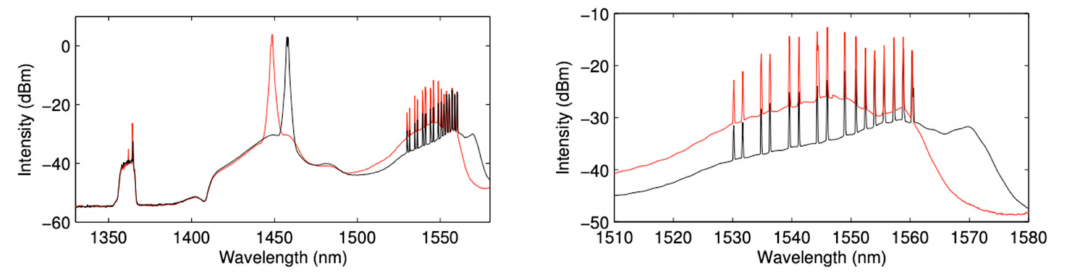
Figure 2. The Raman gain shift using FBGs centered at 1448 nm (red) and 1458 nm (black). The right figure is zoomed on the 16 WDM signals wavelength